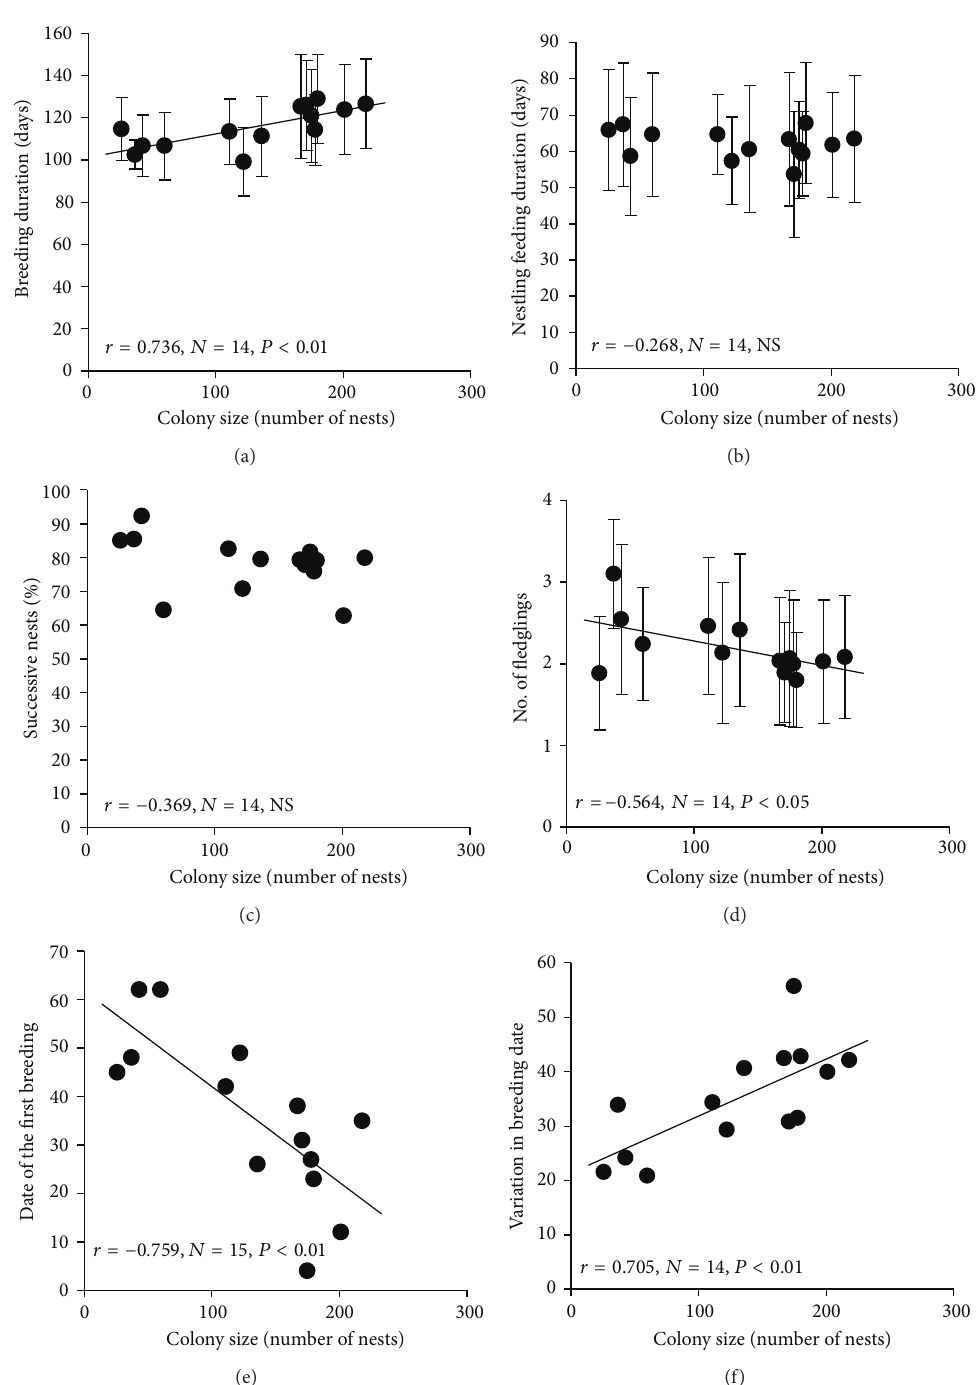
Figure 2: Relationships between colony size and (a) breeding duration, (b) nestling feeding duration, (c) proportion of successfully fledged nests, (d) number of fledglings per successful nest, (e) date of the first breeding in the colony, and (f) coefficient of variation in the date of the onset of breeding by individuals. Bars indicate ±